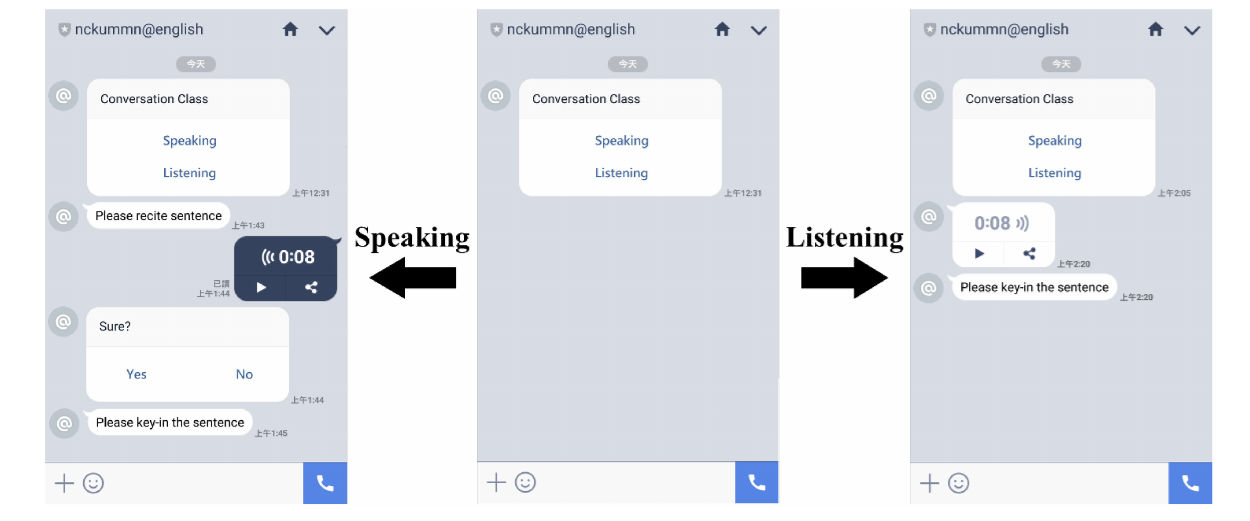
FIGURE 3 | LINE ChatBot contextual learning